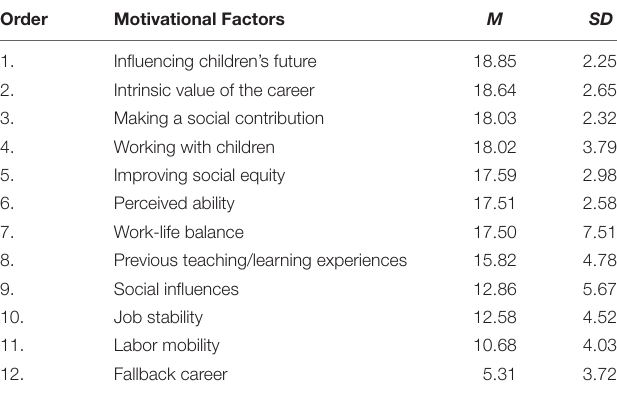
TABLE 2 | Means and standard deviations of motivational